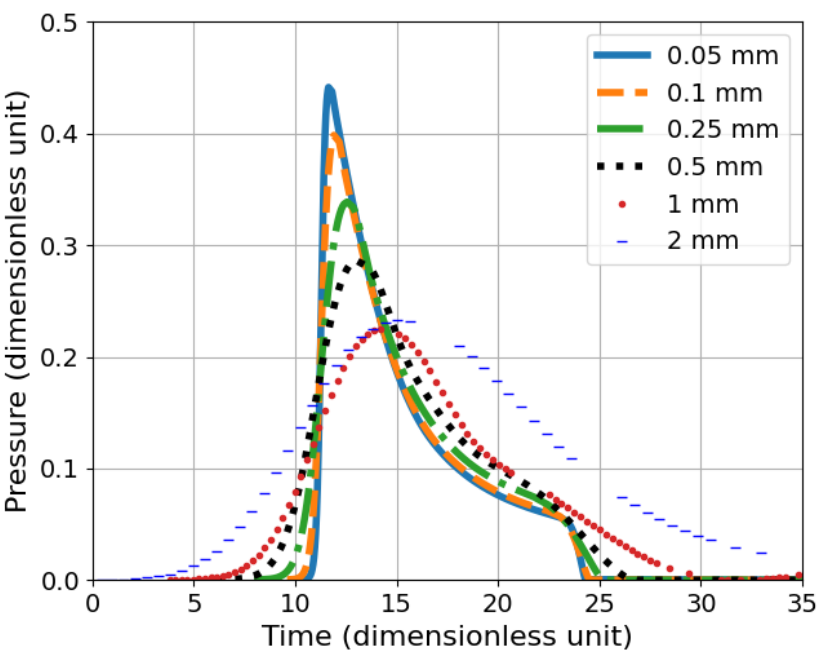
Figure 13. Mesh convergence study using 2D SPEED ® simulation (dimensionless unit), the explosive is set at 40 charge radii from the numerical gauge.